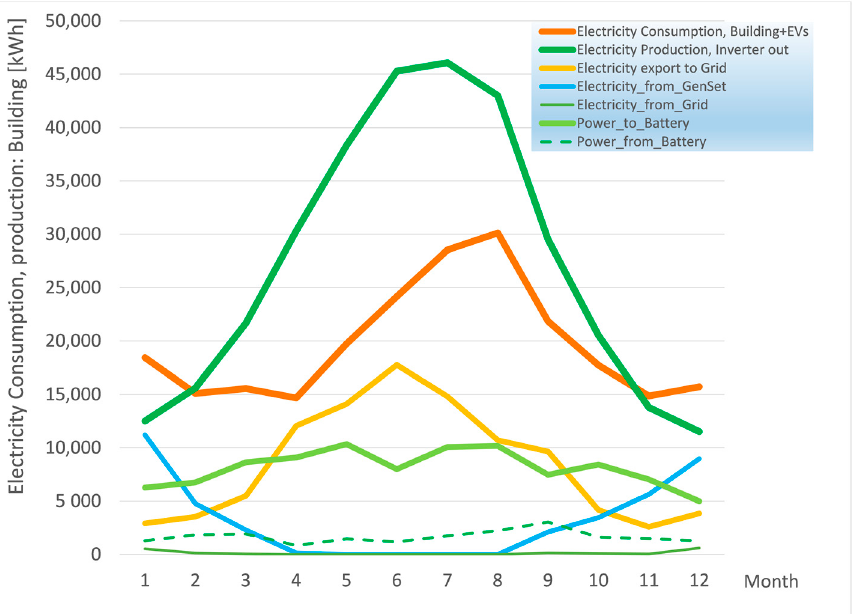
Figure 11. Monthly electricity supplied from the Genset, imported and exported to the grid, em- ployed for EV charging and received from EV discharging (50 kW Genset rating). for EV charging and received from EV discharging (50 kW Genset rating).